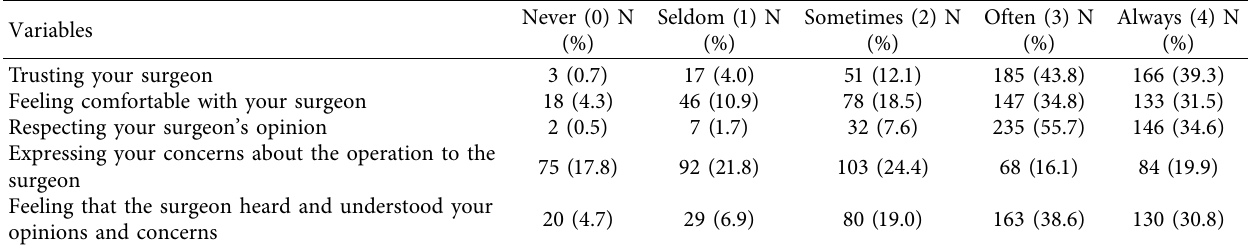
Table 4: Patient-physician relationship of surgical patients in Dessie City Administration public hospitals, Northeast Ethiopia, 2021 ( N � 422).